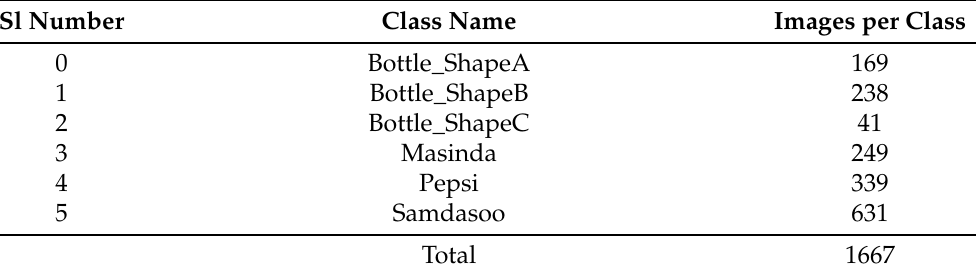
Table 1. Detailed specification of original dataset.